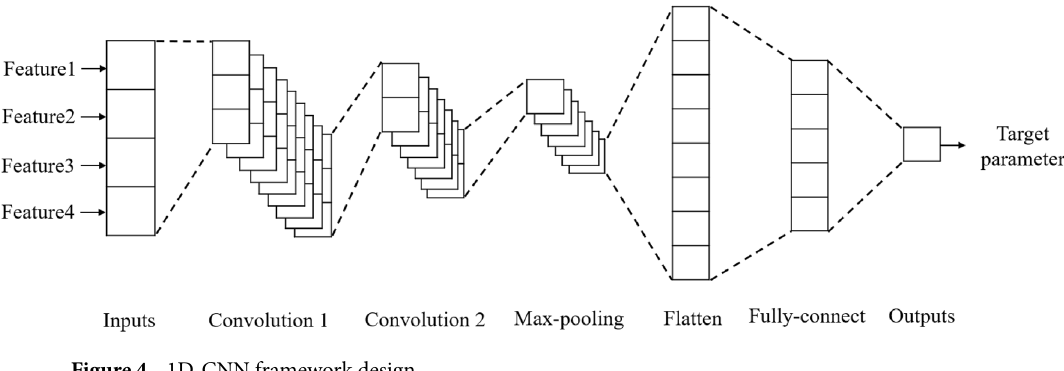
Figure 4. 1D-CNN framework